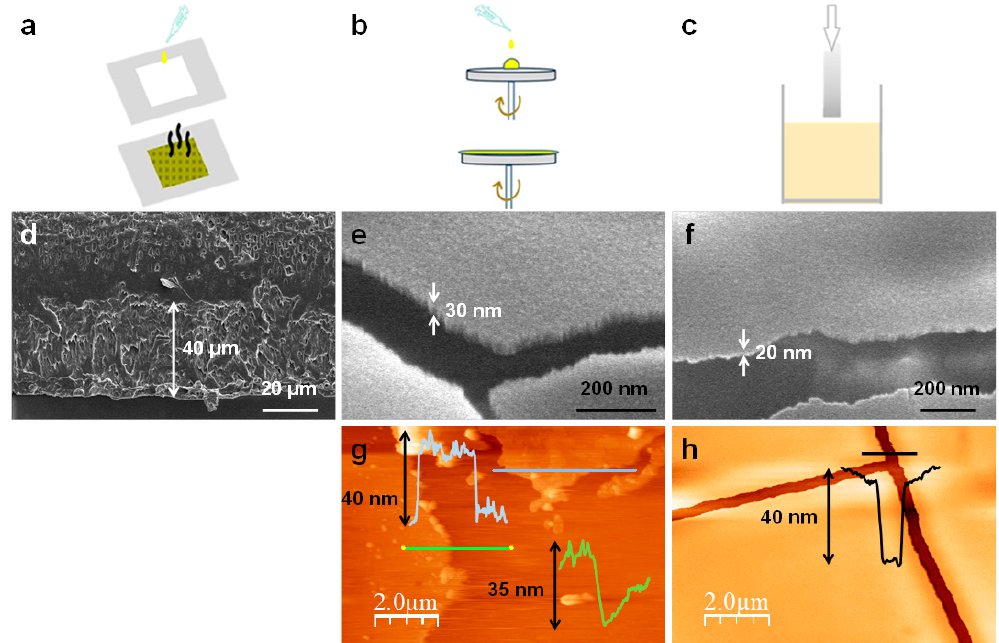
Figure 5. ( a – c ) Scheme of the deposition methods used to get [Cu 2 I 2 (Apyz)] n @PLA thin films: ( a ) Drop casting, ( b ) spin coating, ( c ) dip coating. ( d ) FE-SEM image of the [Cu 2 I 2 (Apyz)] n @PLA film with 30% w / w of [Cu 2 I 2 (Apyz)] n obtained using drop-casting as deposition method. ( e , g ) FE-SEM ( e ) and AFM ( g ) images of the [Cu 2 I 2 (Apyz)] n @PLA thin film with 30% w / w of [Cu 2 I 2 (Apyz)] n obtained using spin-coating as deposition method. ( f , h ) FE-SEM ( f ) and AFM ( h ) images of the [Cu 2 I 2 (Apyz)] n @PLA thin film with 30% w / w of [Cu 2 I 2 (Apyz)] n obtained using dip-coating as deposition method.